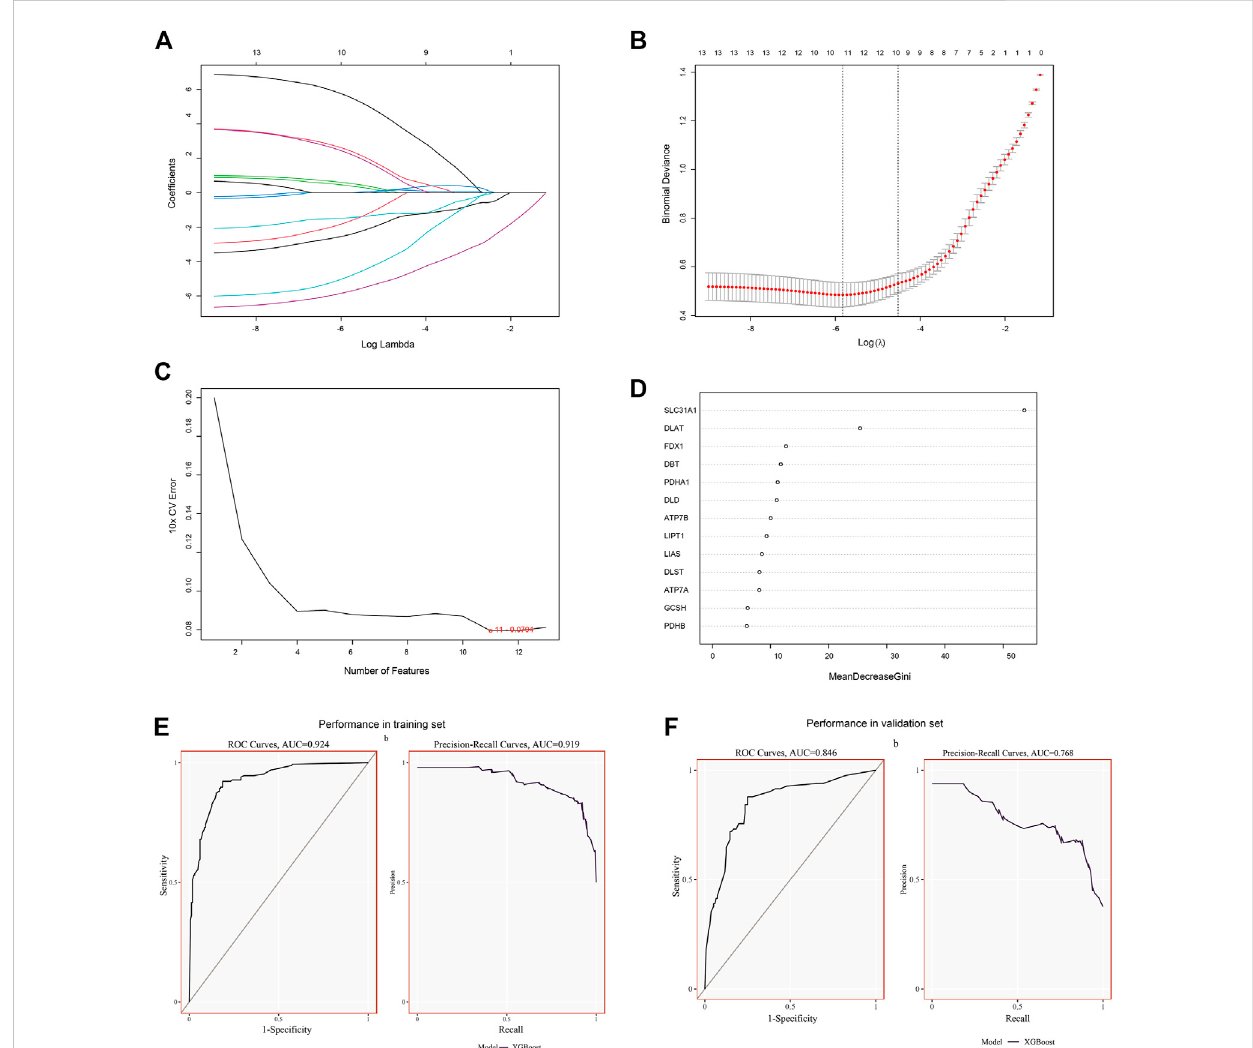
FIGURE 3 Identi fi cationandvalidationofsignaturegenes. (A) Cross-validation forCRGs. (B) LASSOcoef fi cientspectraofCRGs,andthe λ valuewascon fi rmed as 0.010869. (C) The SVM-RFE algorithm was used to identify CRGs. (D) The RF algorithm was used to identify CRGs. (E) The performance of signature genes through the XGBoost model in the training set data of GSE141910 with AUC of 0.924 and PR of 0.919. (F) The performance of the signature genes by the XGBoost model in the validation data of GSE57338 with AUC of 0.846 and PR of